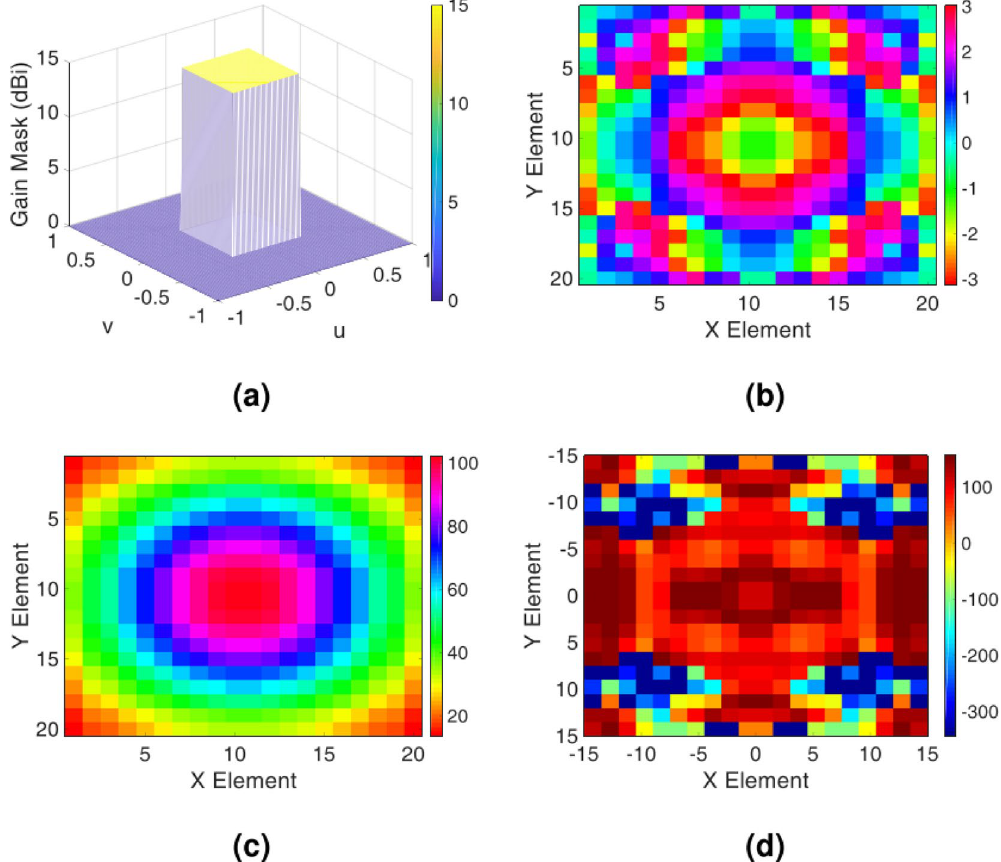
Figure 3. ( a ) The expected object wave in the (u, v) plane; ( b ) the phase and ( c ) amplitude of the overall tangential electric field in hologram plane; ( d ) the impedance distribution of the hologram obtained from the Eq.